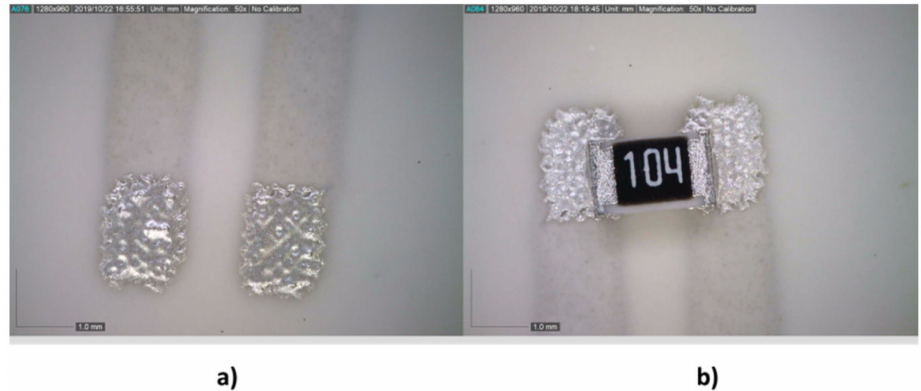
Figure 15. Screen printing of the Inkron IPC-603X on wave reflow footprint: ( a ) after printing; and ( b ) after temperature curing.